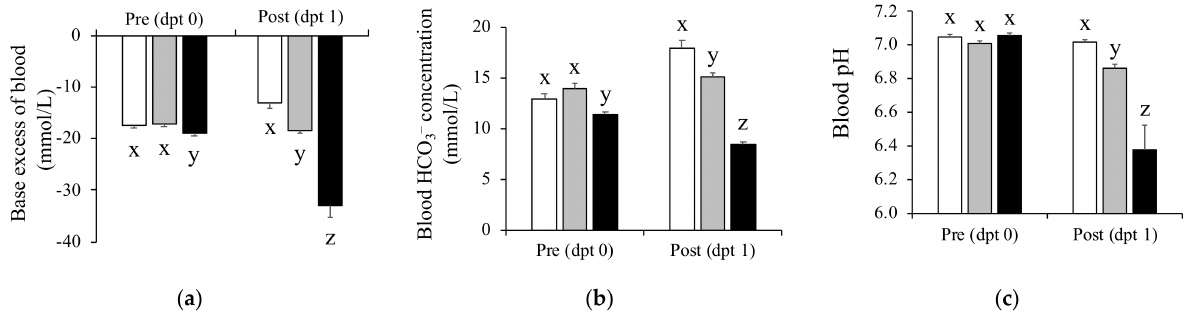
Figure 2. Blood parameters pre- (dpt 0) and post- (dpt 1) rehydration therapy with or without probiotic supplementation. Black bars, untreated control (C; n = 23); gray bars, piglets receiving oral and abdominal rehydration therapy (OA; n = 31); white bars, piglets receiving oral and abdominal rehydration therapy (probiotics added to the oral solution; OAP; n = 49). ( a ) Base excess of blood; ( b ) bicarbonate ion (HCO 3 − ) concentration in blood; ( c ) pH of blood. Bars with different letters are significantly different ( p < 0.05) at each time point. Data are shown as the means ± standard